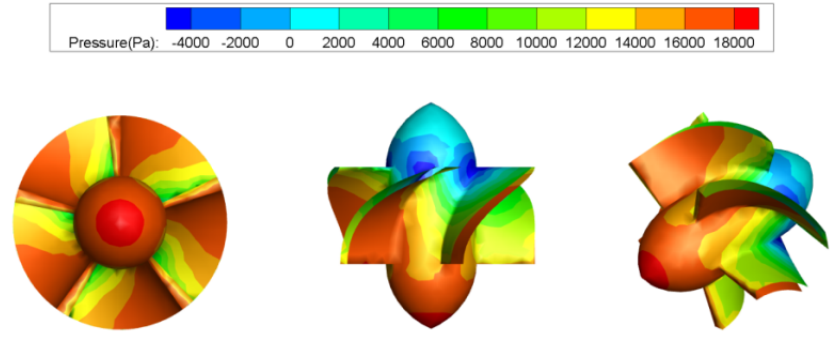
Figure 18. Guide vane pressure changes cloud map.